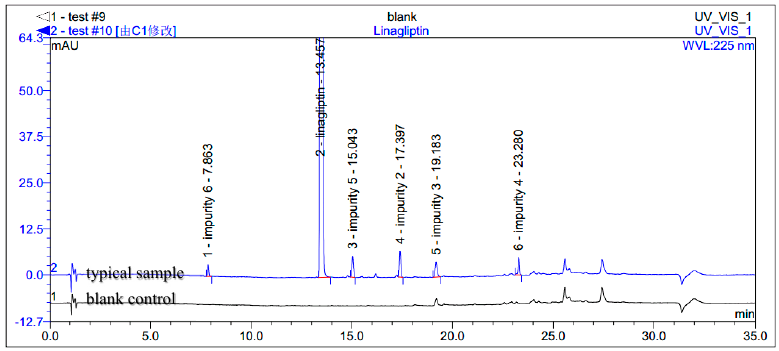
Figure 2. Typical HPLC chromatogram of linagliptin with impurities.